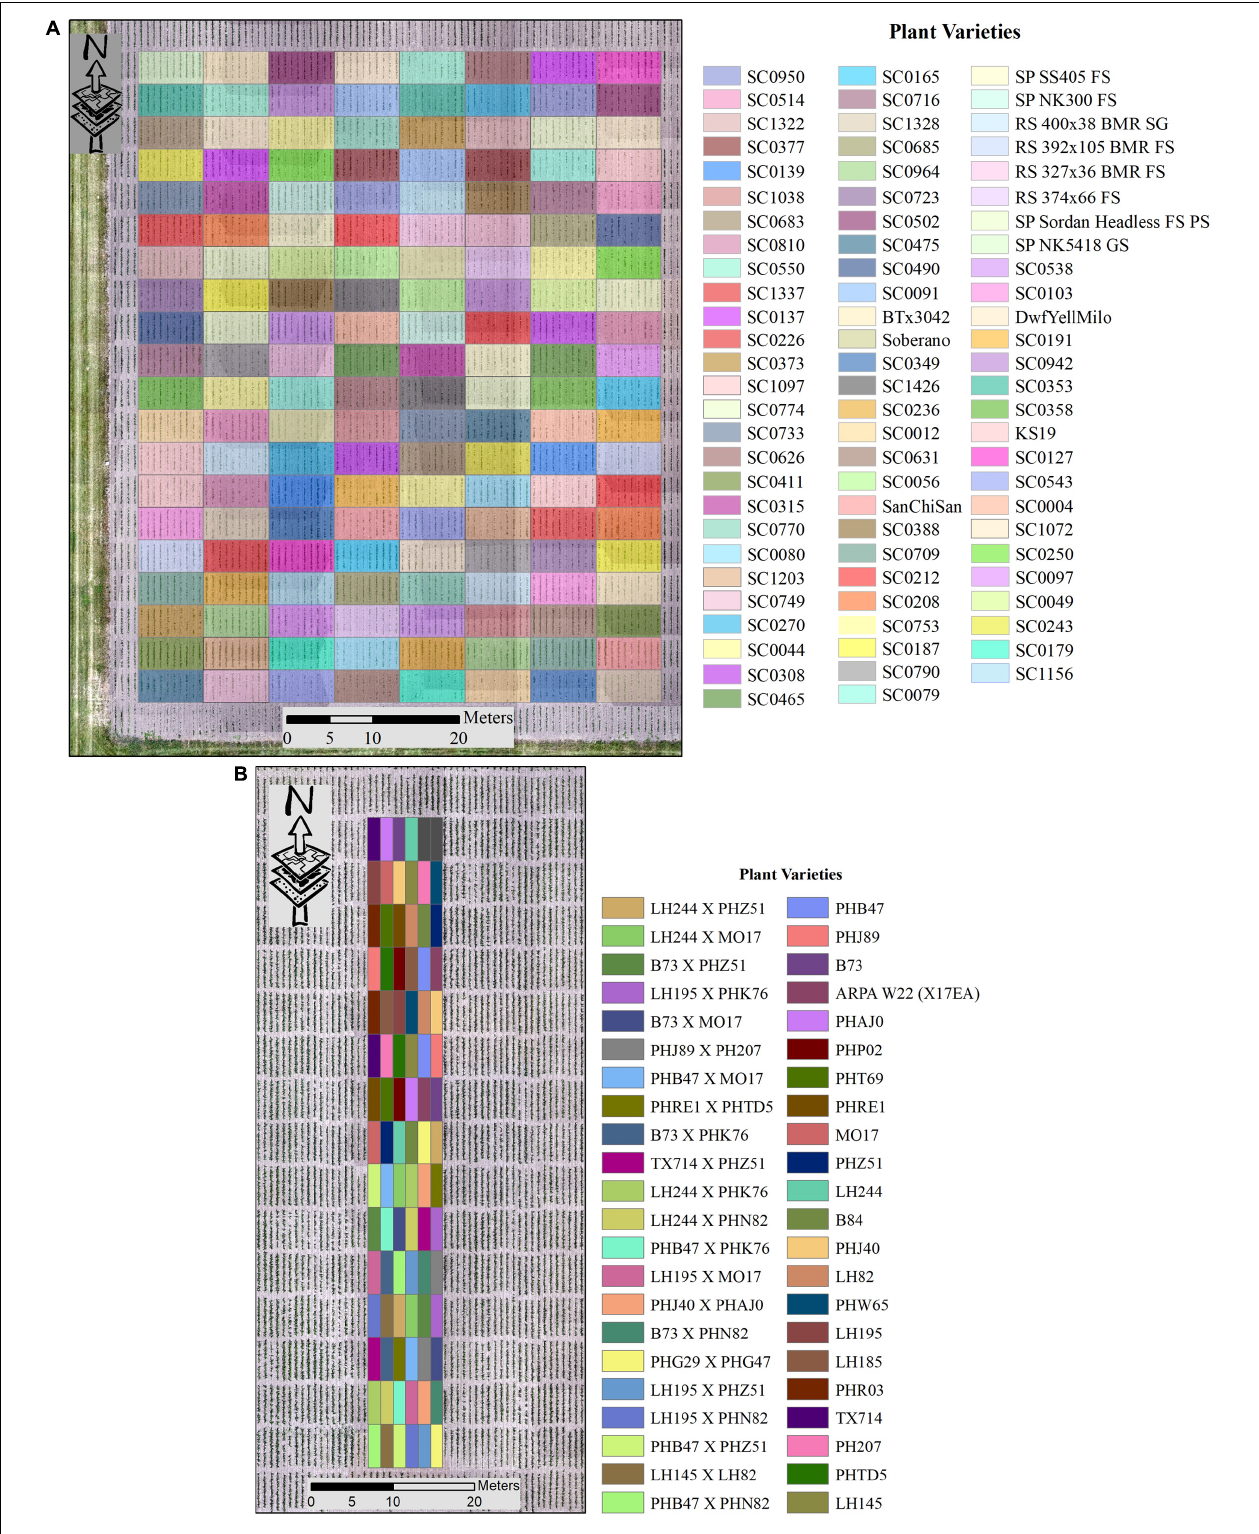
FIGURE 1 | Plot variety layout (A) SbDivTc_Cal and (B) HIPS.